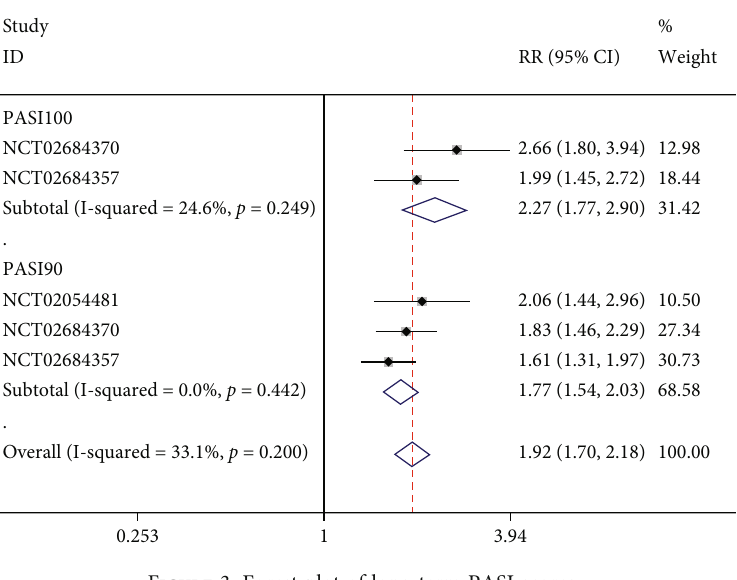
Figure 3: Forest plot of long-term PASI scores.